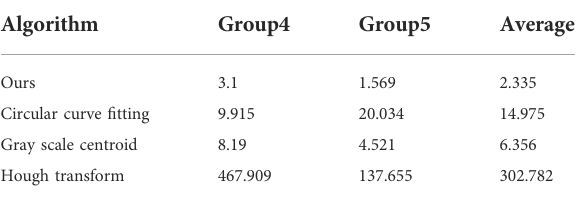
TABLE 2 The Residual sum of squares of the results under different